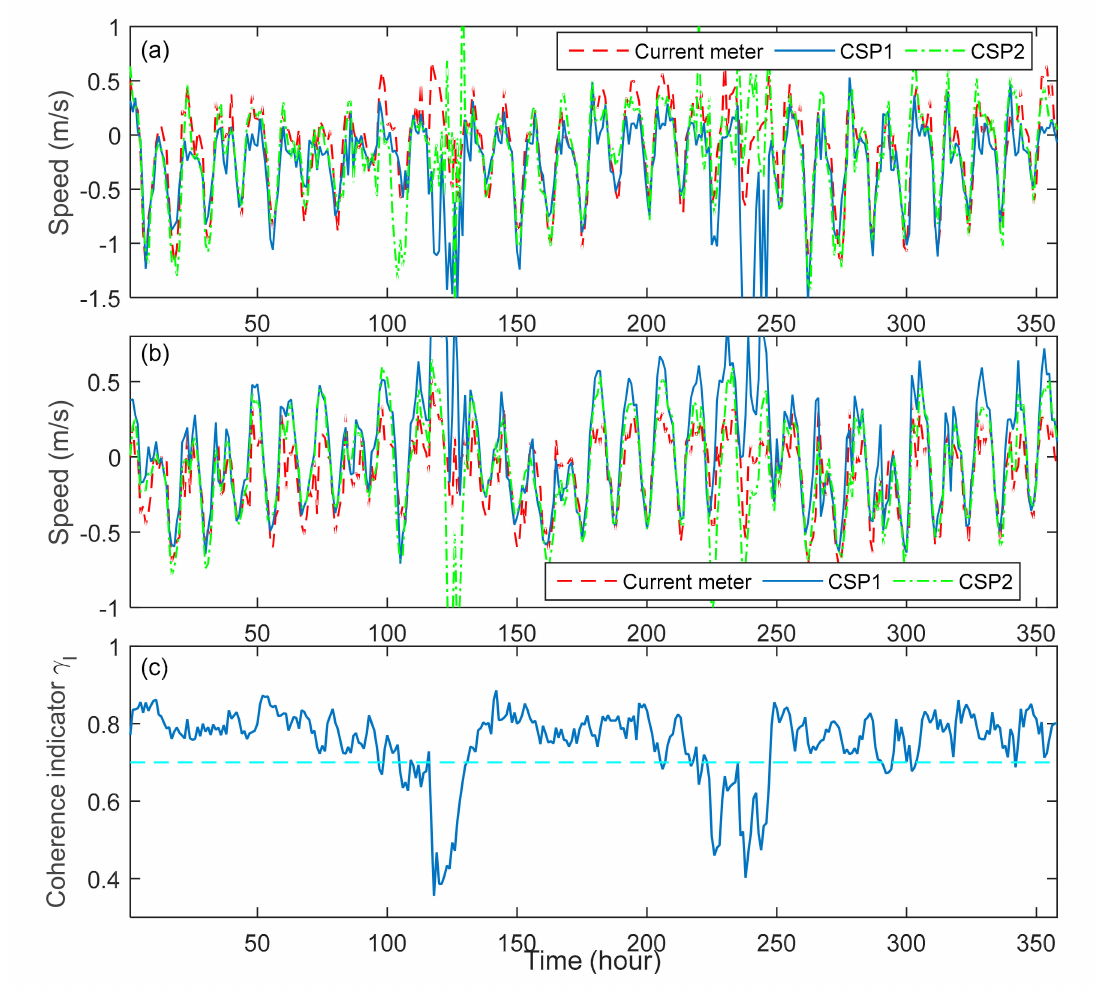
Figure 3. Time series of ( a ) north-south (NS) velocity and ( b ) east-west (EW) velocity measured by a current meter, and those retrieved from X-band marine radar image sequences using di ff erent methods. ( c ) Time series of the coherence indicator; the cyan dashed line marks the coherence of